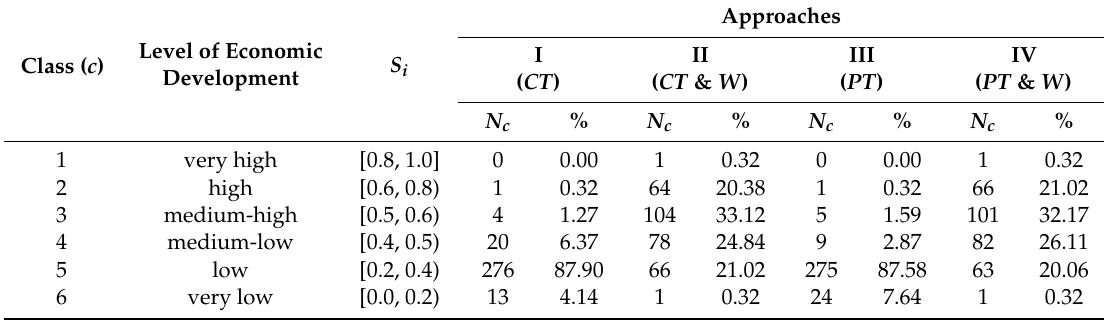
Table 5. Typological classification of districts in Poland in terms of the level of economic development at national level in 2017.